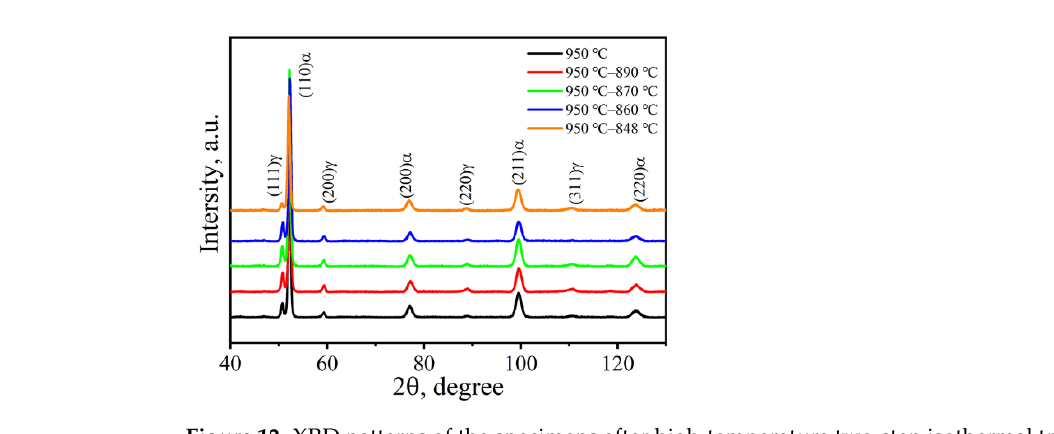
Figure 12. XRD patterns of the specimens after high-temperature two-step isothermal treatment. Table 2. The volume fraction of the retained austenite of the samples after high-temperature two- step isothermal treatment.